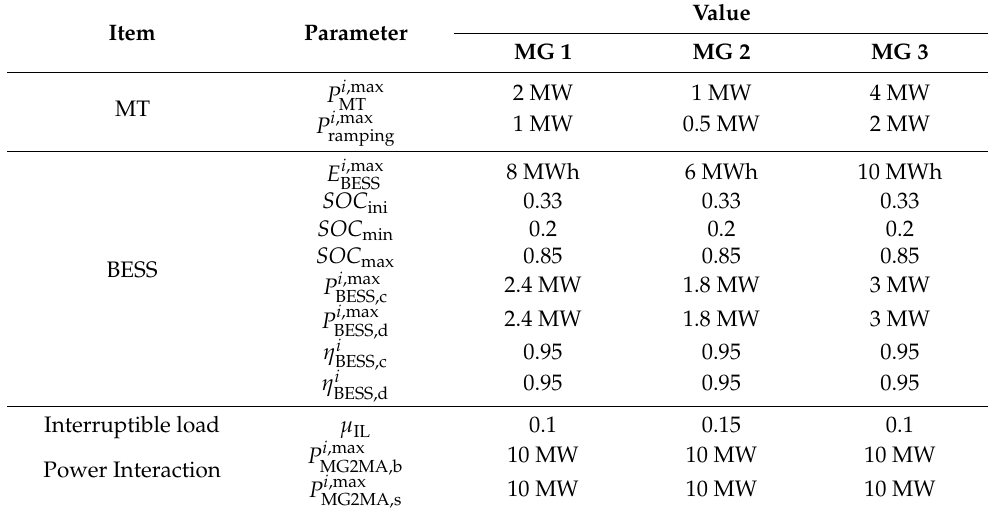
Table 1. Technical parameters of MG.